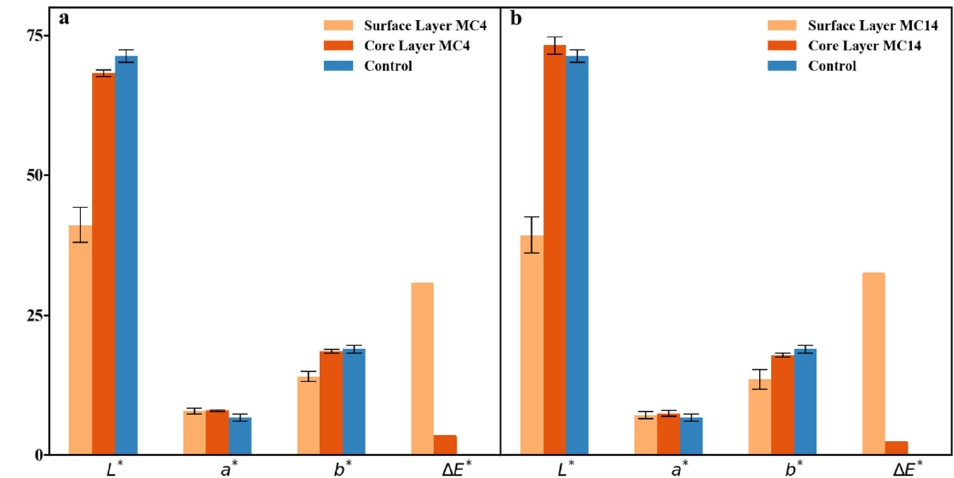
Figure 5. Colour parameter comparison between the control sample and: ( a ) sample MC4; ( b ) sample MC14.